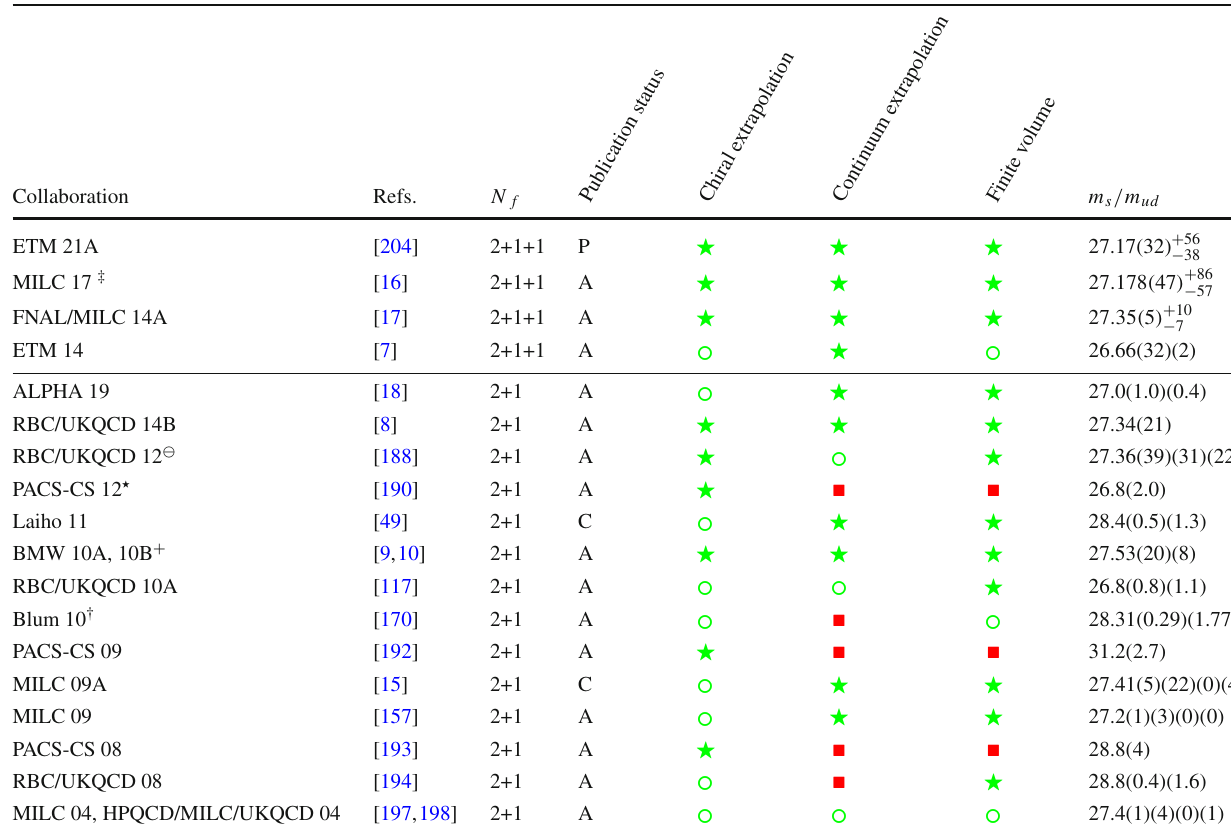
Table 8 Lattice results for the ratio m s / m ud